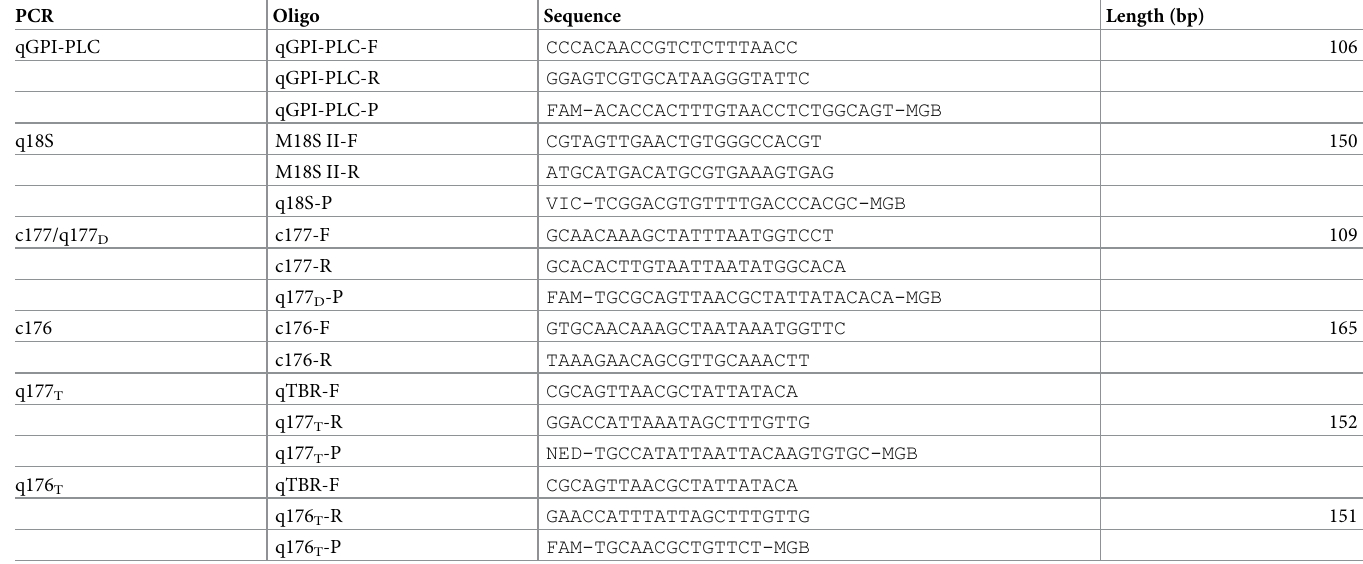
Table 1. Primers and probes for PCR and qPCR detection of target sequences of GPI-PLC, 18S rDNA, and the 176 bp and 177 bp TBR groups in Trypanozoon